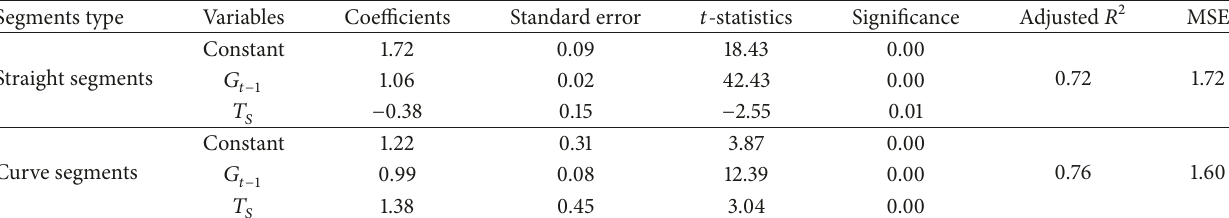
Table 2: Results of regression models for repaired segments.